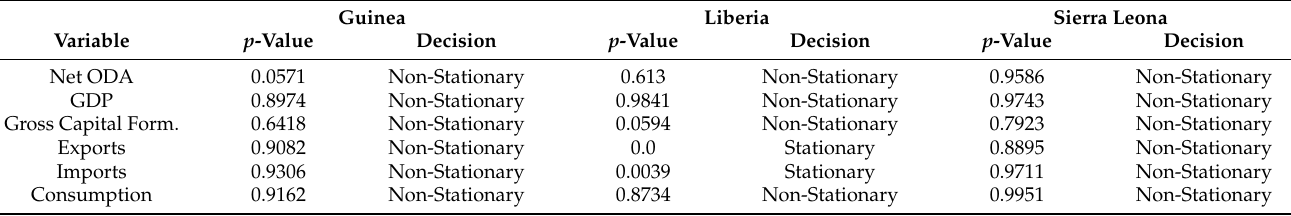
Table 2. Analysis of the stationarity of time series: step 1.